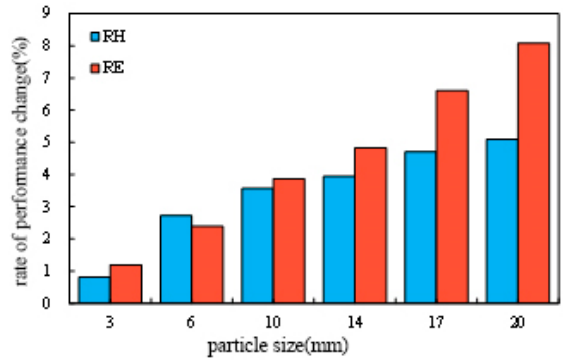
Figure 6. Influence of different solid-phase particle sizes on pump performance.